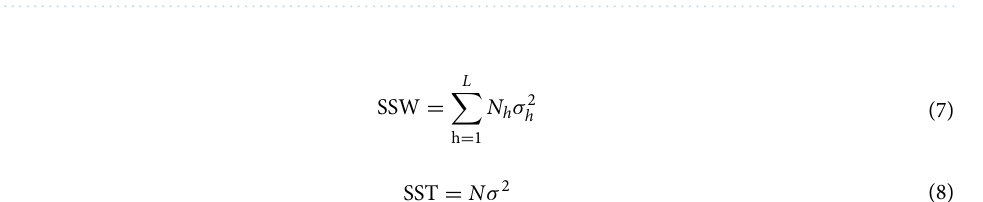
Table 1. Exposure parameters, reference dose ( RfD ) and slope factor ( SF ) of